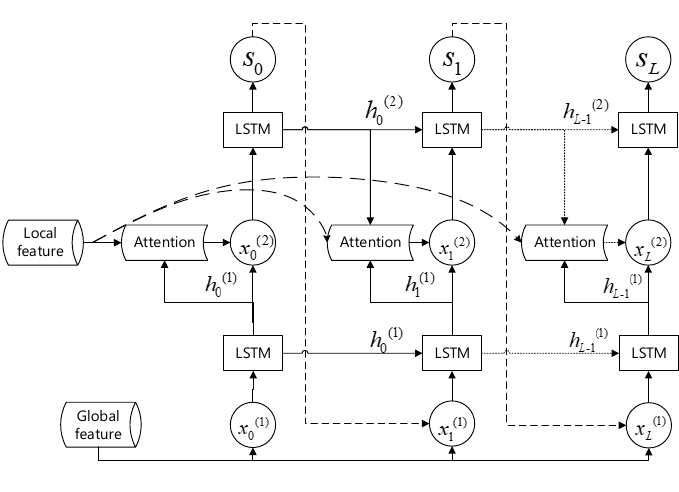
Figure 2. Language Generation